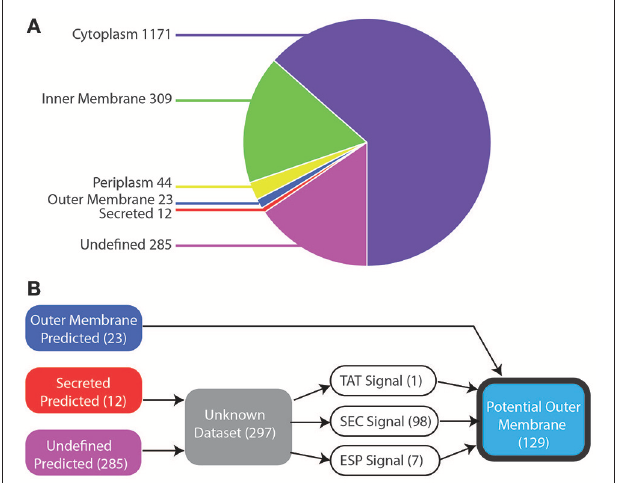
FIGURE 1 | Bioinformatic localization prediction. (A) Localization of V. parvula proteome predicted by PSORT, CELLO, SOSUI, LipoP, TMHMM, and BOMP (see text for details). (B) Strategy for refining prediction for the sequences with undefined localization (see text for details).